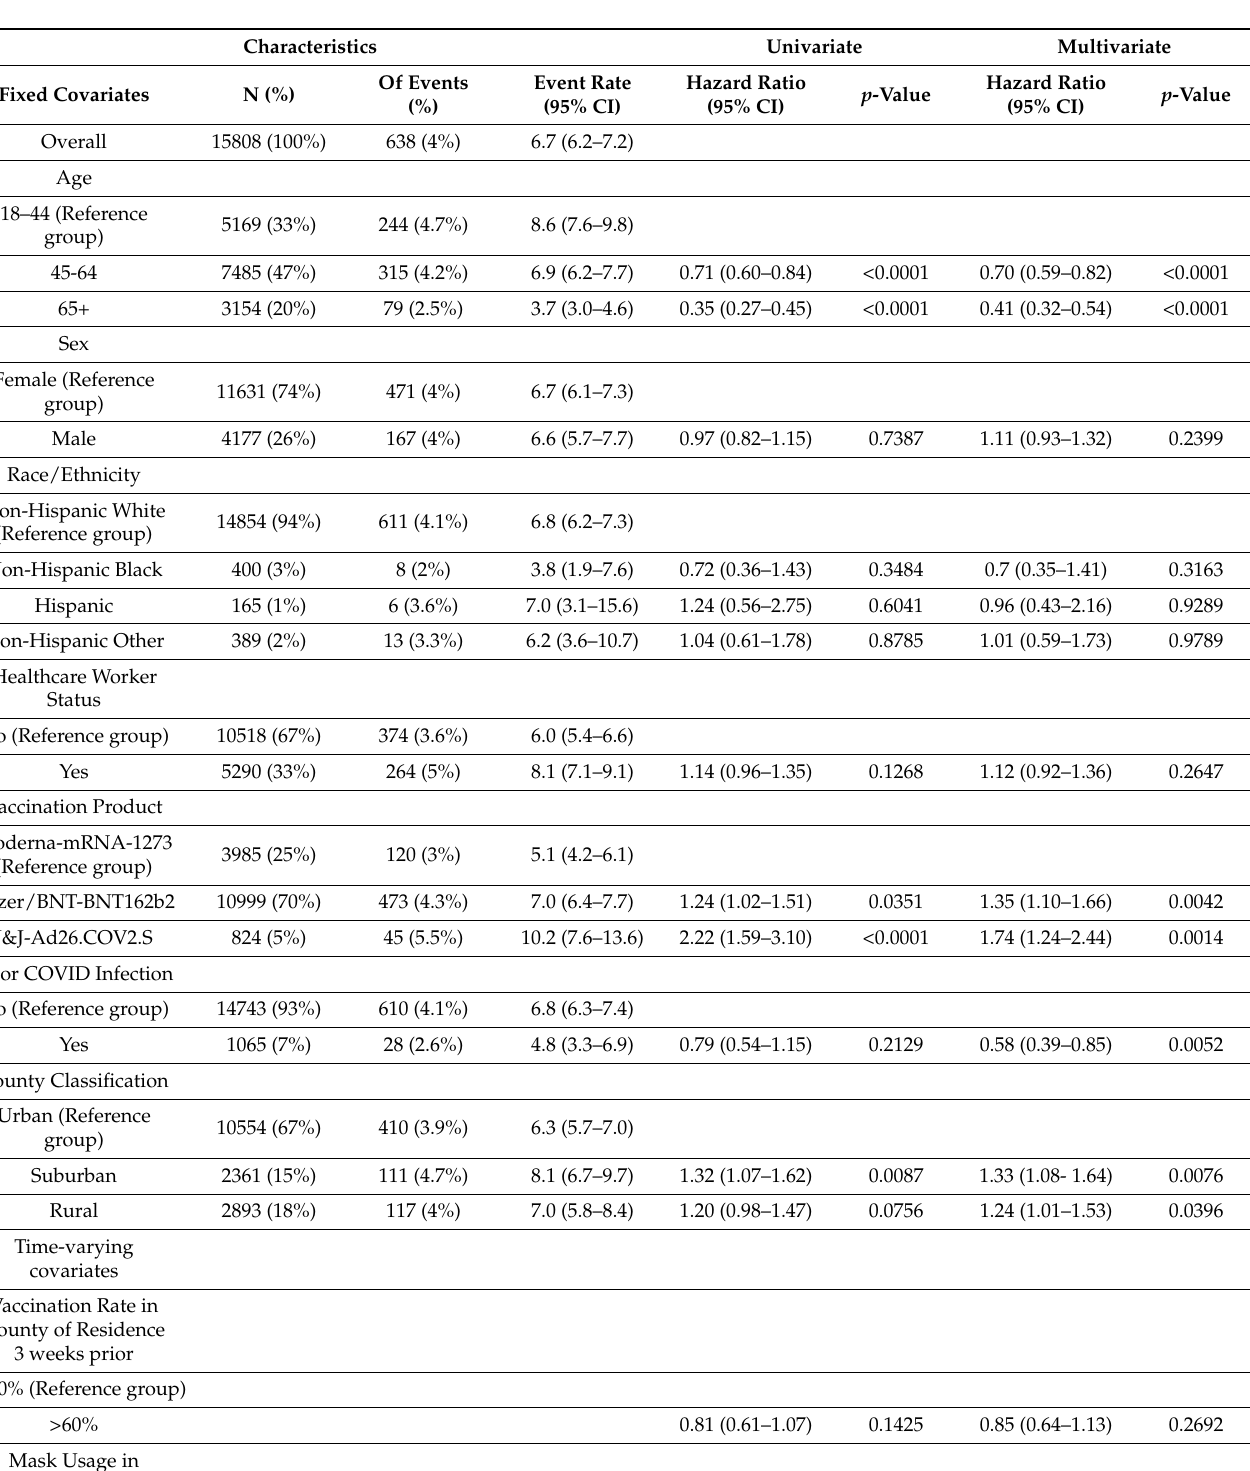
Table 1. Infection rate per 100 person-years overall and by factors, and factors associated with SARS-CoV-2 infection after